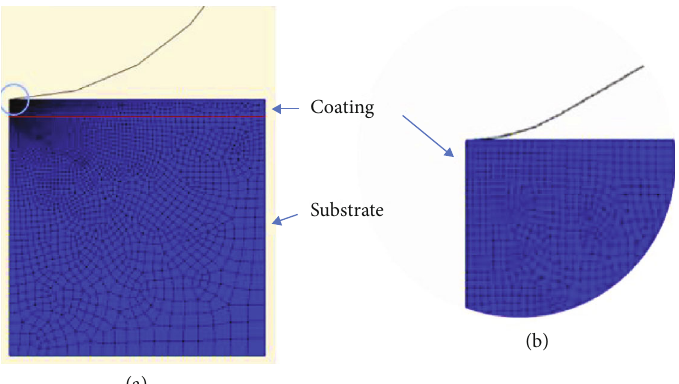
Figure 1: Finite element mesh for a spherical tip indenting hard coating on a soft substrate. (a) The overview of the coating/substrate system. (b) Enlarged details of coating elements underneath the spherical